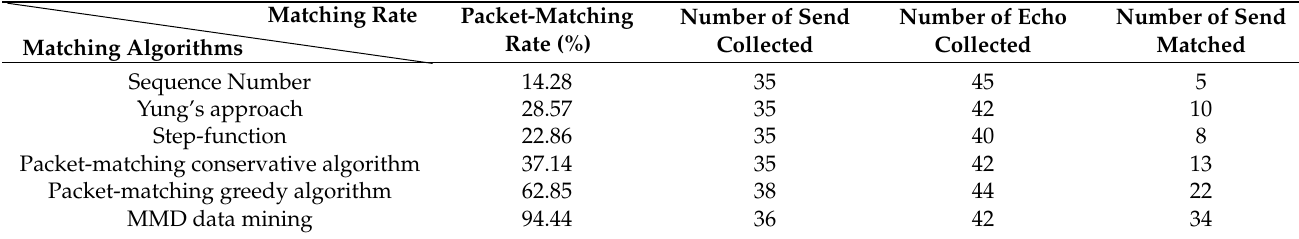
Table 6. Packet-Matching algorithm performance comparison under the